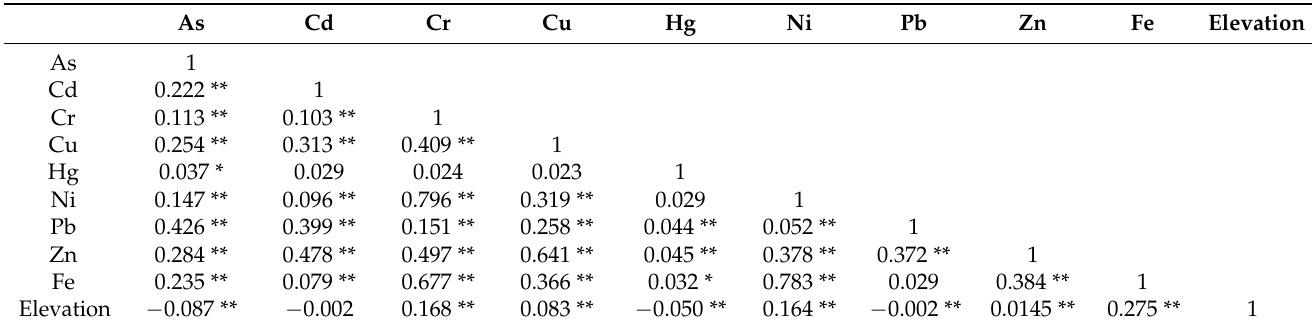
Table 9. Correlation Matrix for Heavy